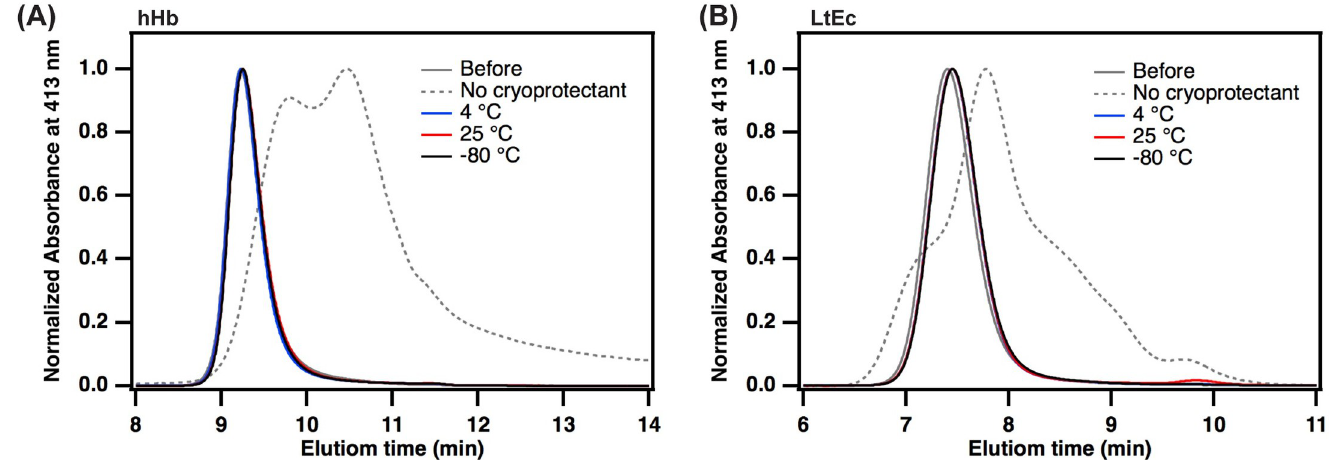
Fig 2. SEC-HPLC analysis of (A) hHb and (B) LtEc samples post lyophilization stored under different conditions—no cryoprotectant, with cryoprotectant at temperatures of 25˚C, 4˚C, and -80˚C. All SEC-HPLC curves are after 6 months of storage under the respective storage conditions.